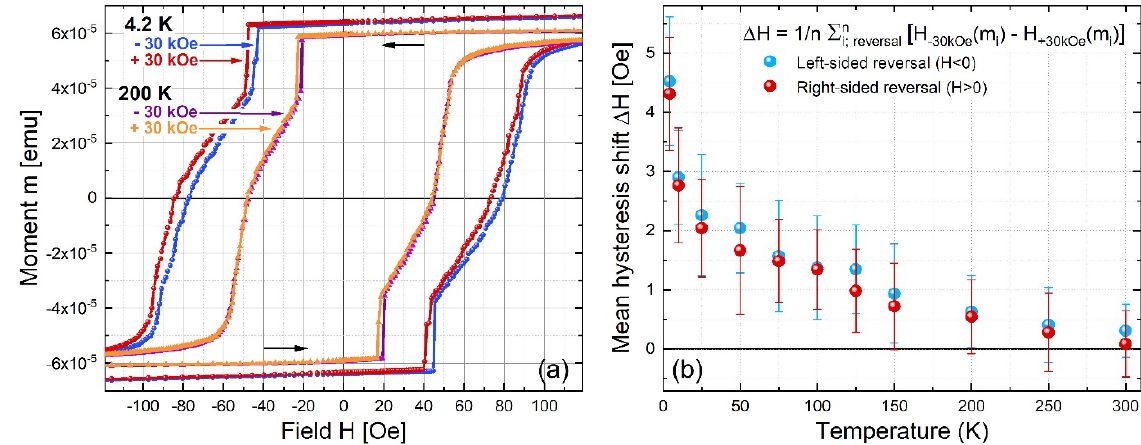
Figure 6. ( a ) Magnetization reversal loops (maximum fields: +2 kOe → − 2 kOe → +2 kOe) measured after cool-down from 400 to 200 K, and from 400 to 4.2 K, respectively. For each temperature, the cool-down is done twice, with initially positive (+30 kOe) and negative ( − 30 kOe) in-plane fields, respectively. Below 200 K a distinct shift and a small change of the reversal curve shape between positive and negative field-cooled loops is observed. ( b ) Temperature dependent mean hysteresis shift between − 30 kOe and +30 kOe field-cooled magnetization reversal curves. For a reliable quantification of the shift with respect to the change in the reversal curve’s shape (Figure 6a), field shifts for multiple fixed moments (within the range of magnetization reversal) are averaged instead of using the difference of the coercive fields (at m = 0) only. This calculation is separately done for both magnetization reversals, H < 0 and H > 0, respectively, and shows the same sign and a comparable size. The shift increases towards lower temperature, indicating the presence of a growing exchange bias at the Fe/Fe 3 O 4 /Pt interfaces.